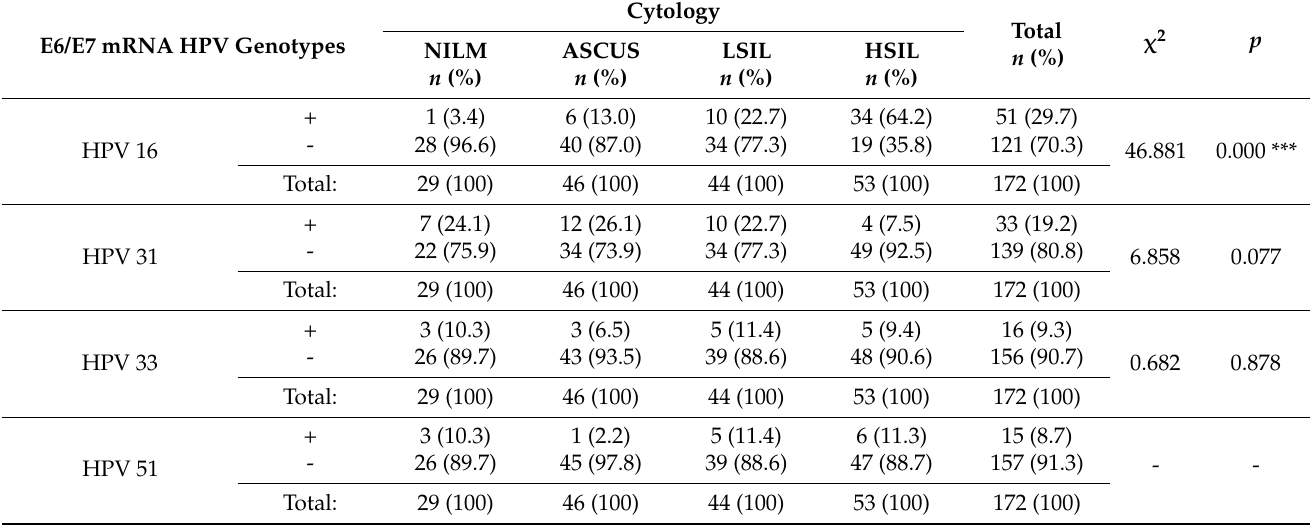
Table 7. Distribution of E6/E7 mRNA HR HPV according to